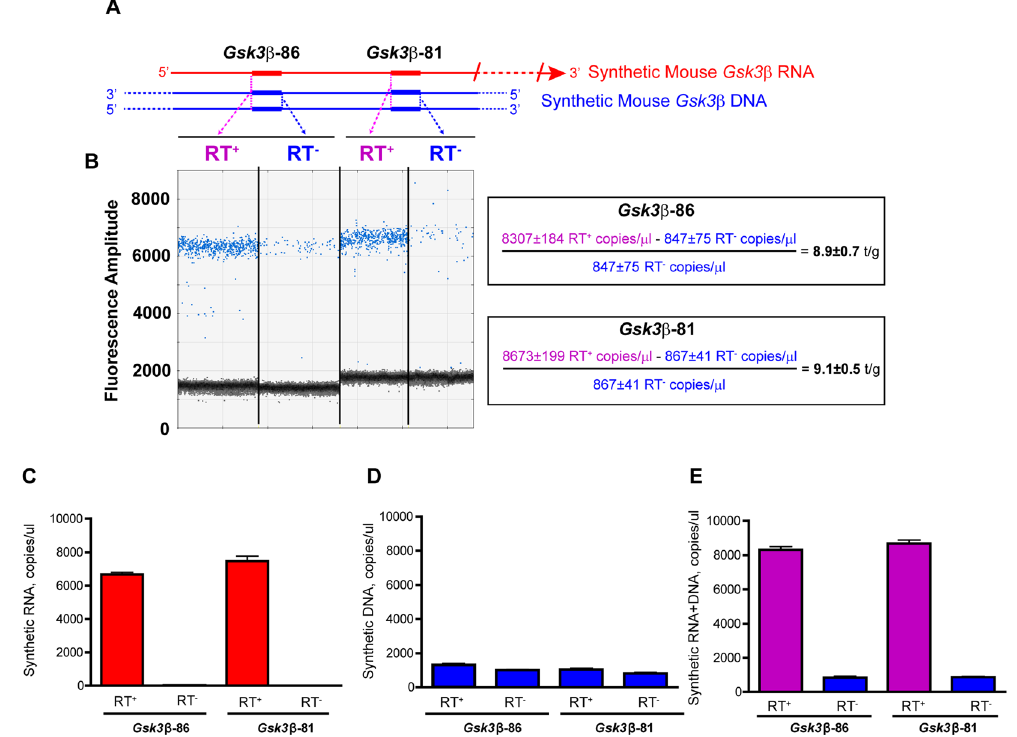
Figure 3. Accuracy of the Selfie-dPCR method for quantifying absolute quantities of synthetic RNA and DNA by using two different amplicons in the same target template. ( A ) Schematic diagram showing the locations of the two amplicons within the synthetic template of mouse Gsk3 β RNA and DNA and illustrating Selfie- dPCR amplification of RNA + DNA in the RT + reaction and only DNA in the RT − reaction for each amplicon. ( B ) Scatter plot showing droplet digital PCR analysis of Gsk3 β DNA + RNA (RT + ) and Gsk3 β DNA (RT − ) for Gsk3 β -86 (left two panels) and Gsk3 β -81 (right two panels) in a sample containing both synthetic DNA and RNA. Blue dots indicate droplets containing target template for which end-point PCR has produced an amplicon. Selfie-dPCR calculation shows that the numbers of Gsk3 β transcripts per gene obtained for each amplicon are not significantly different (p > 0.05, n = 3). ( C–E ) Accuracy of Selfie-dPCR assessed by measuring known amounts of RNA ( C ), DNA ( D ) and combined DNA + RNA ( E ) in RT + and RT − reactions using two different amplicons ( Gsk3 β -86 and Gsk3 β -81). No significant differences between the amplicons were found